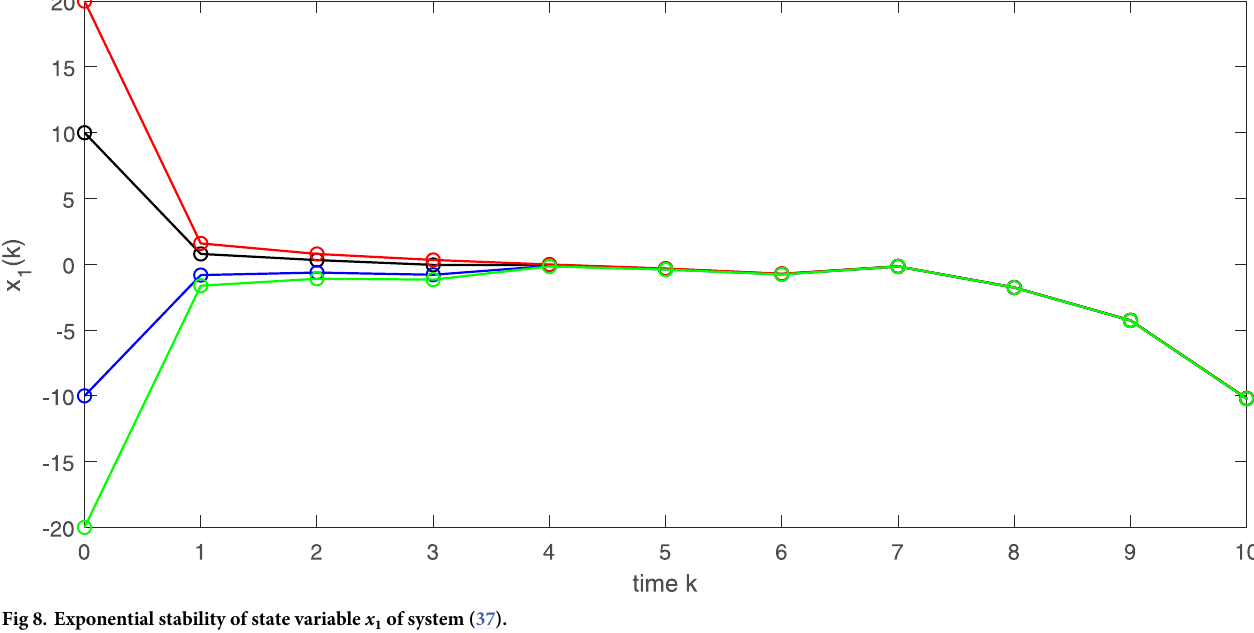
Fig 8. Exponential stability of state variable x 1 of system